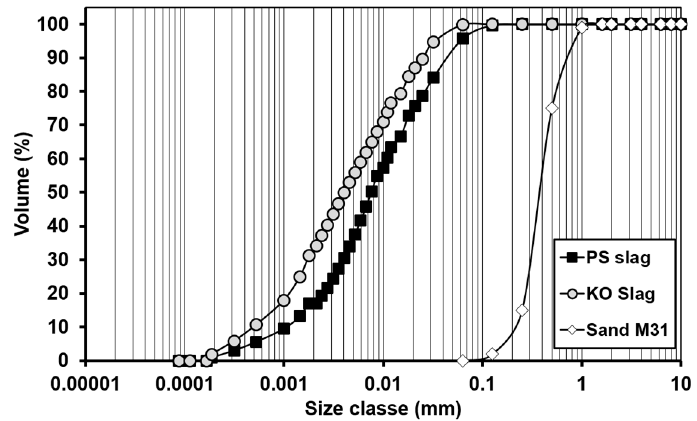
Figure 1. Precursors and aggregates particle size distribution.